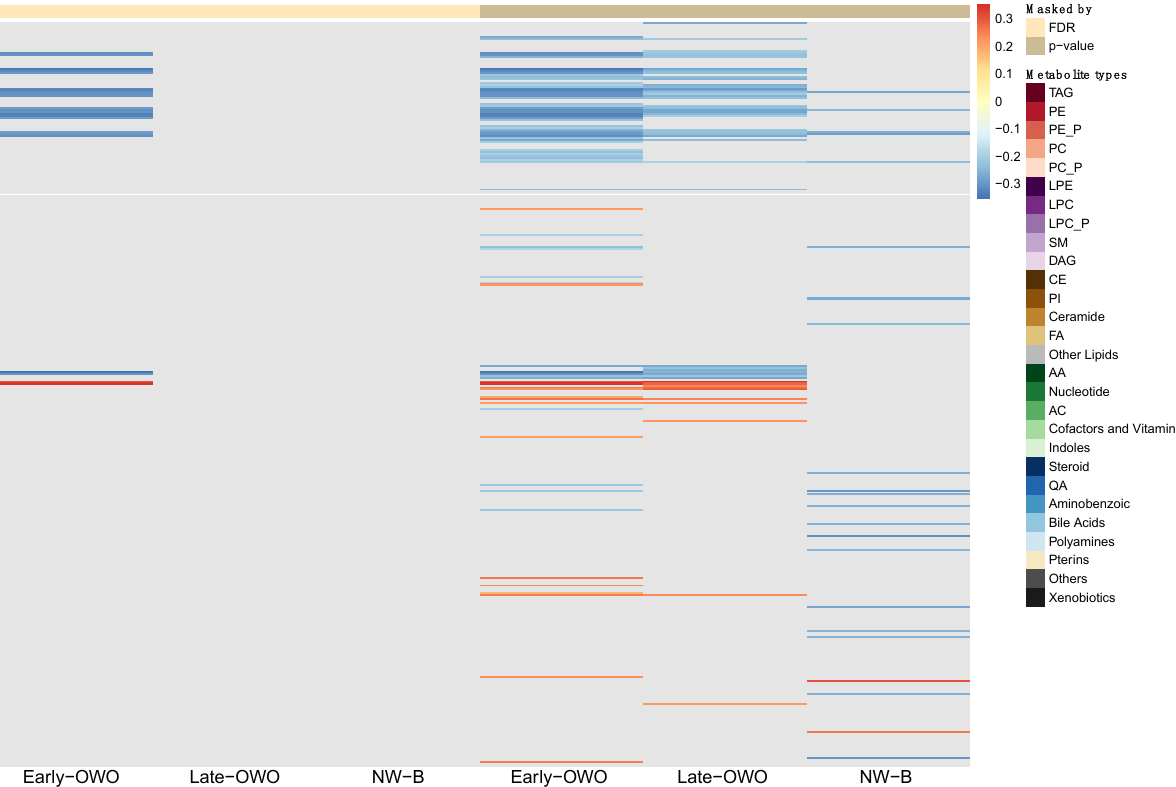
Figure 2. Longitudinal trajectory analysis: Heatmap of the effect size of metabolites on BMI trajectory (4 groups) masked by non-significance on the horizontal axis. The vertical axis represents the 376 metabolites which are ordered based on metabolite types. The effect size of the association between each metabolite and child BMI trajectory is the beta coefficient from the multinormal logistic regression (reference group is NW-A, i.e., the purple line in Figure 1B). The color scheme for effect size is continuous such that red and blue indicate positive and negative associations, respectively. The intensity of the color represents the magnitude of the association. For the first 3 columns, the grey color indicates where the overall effect of that metabolite at that BMI trajectory is not statistically significant after adjusting for multiple hypothesis testing across all 376 metabolites (FDR > 0.05); for the last 3 columns, the grey color indicates where the overall effect of that metabolite at that BMI trajectory is not statistically significant without adjusting for multiple hypothesis testing ( p > 0.05).